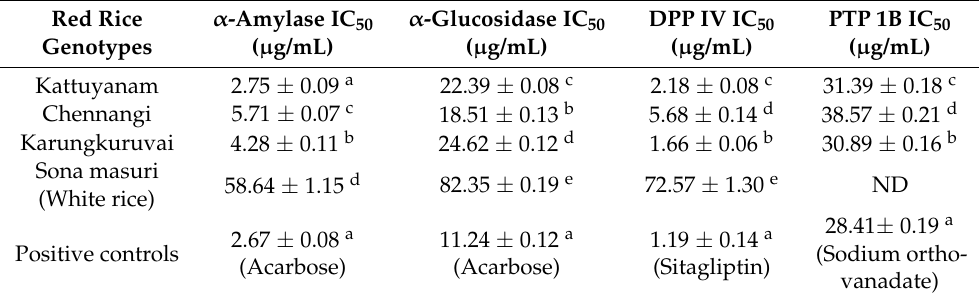
Table 1. Antihyperglycemic potential of the red rice genotypes. Red